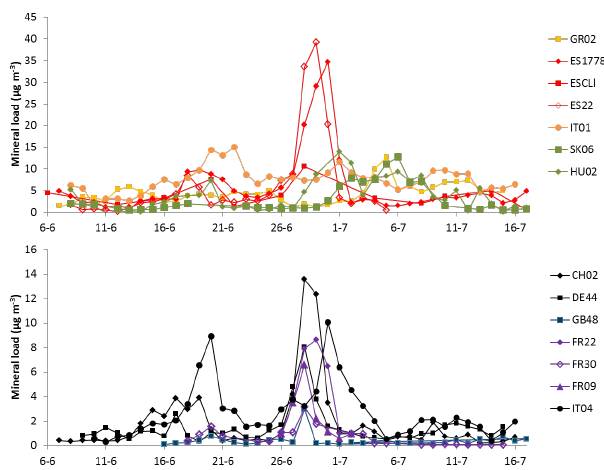
Figure 8. Time series of mineral dust concentrations during the June/July 2012 EMEP IMP at sites affected by Saharan dust out- breaks. Two major dust episodes were observed in June; in both cases, the dust plume moved along a west to east transect.